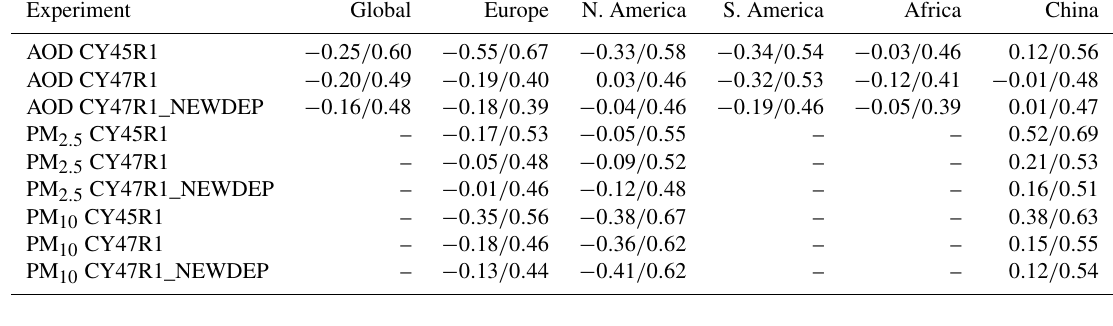
Table 10. Average over 2017 of the modified normalised mean bias (MNMB)/fractional gross error (FGE) of simulated daily AOD at 500nm. PM 2 . 5 and PM 10 . AOD observations are from AERONET level 2. European PM observations are from 65 PM 2 . 5 and 138 PM 10 background rural airbase stations. North American PM observations are from 125 PM 2 . 5 stations and 25 PM 10 background rural stations. Chinese PM observations are from 152 PM 2 . 5 background rural stations.